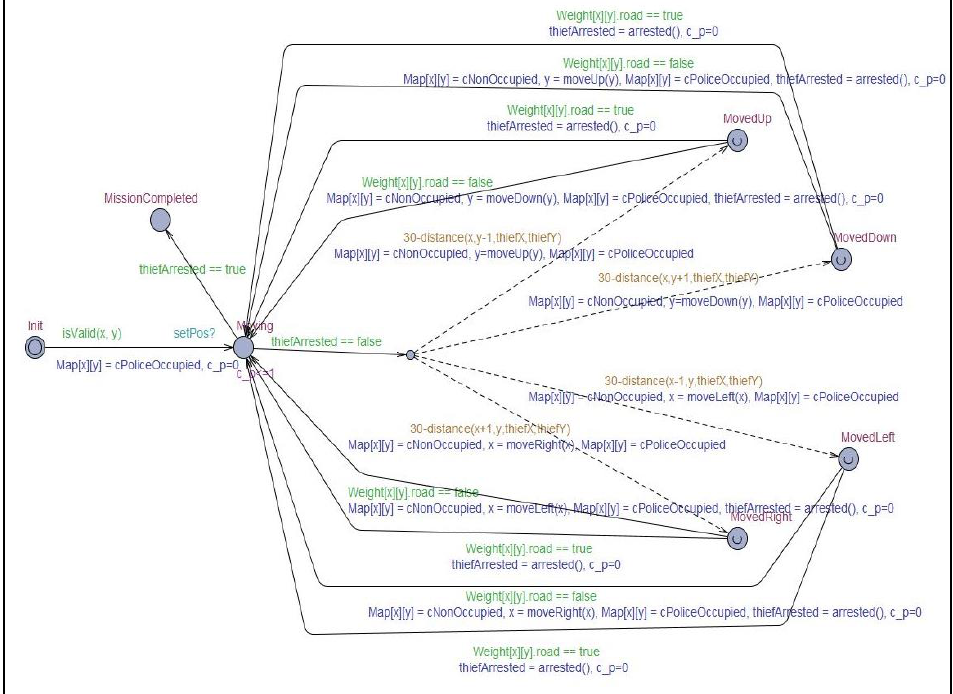
Figure 7. Timed automata for unmanned patrol car participating in IoT collaboration for the arrest of a criminal suspect.